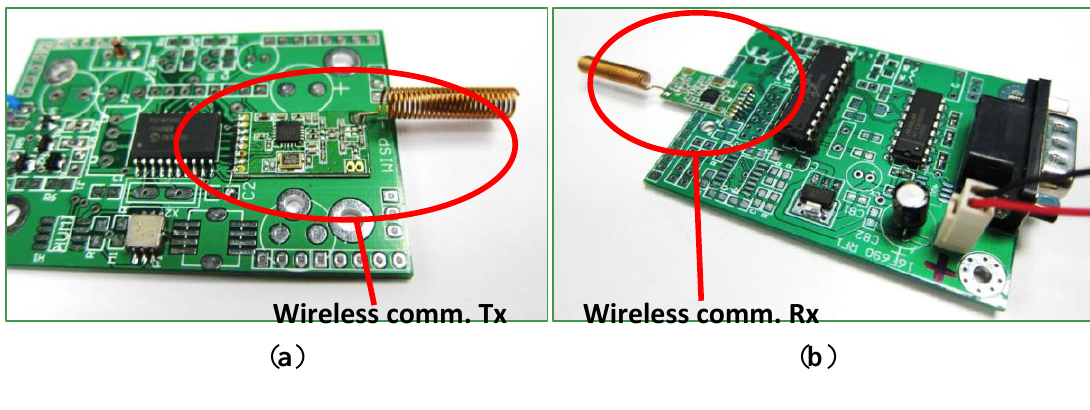
Figure 5. The commercial wireless communication module, the CC1101 module, used as a sensor node to send back sensor data. Paired modules are used to transmit data from the